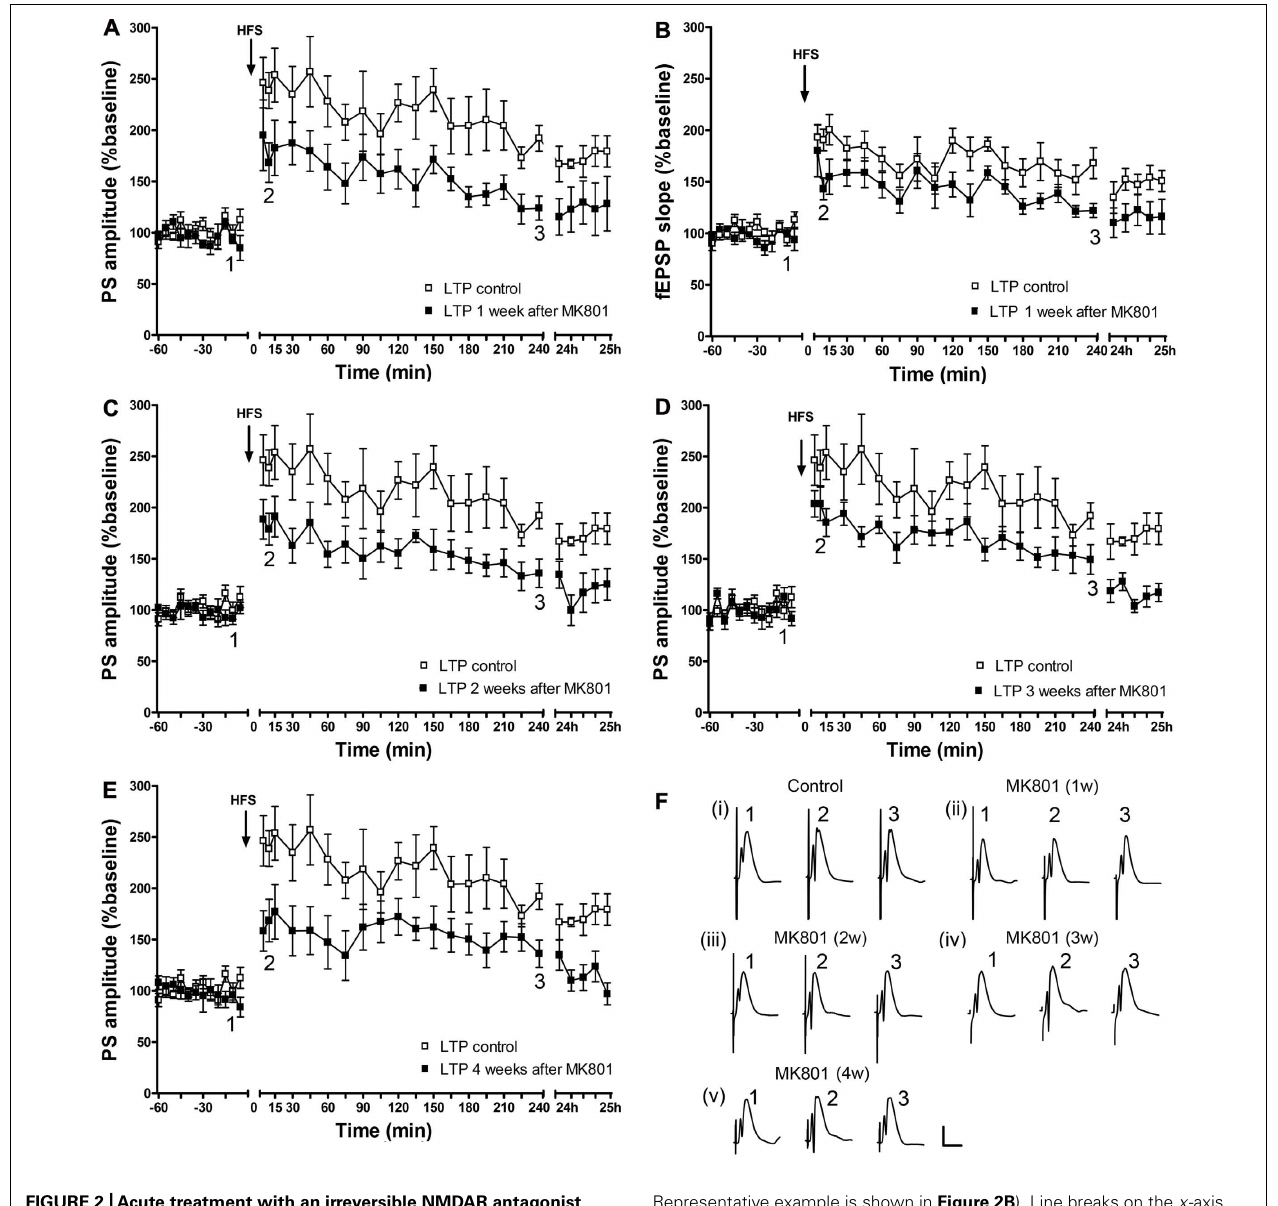
FIGURE 2 |Acute treatment with an irreversible NMDAR antagonist leads to a persistent long-term impairment of LTP in vivo , which lasts for at least 4 weeks. One week after MK801-treatment, LTP of population spike amplitude (A) and of fEPSP (B) are significantly impaired compared to control LTP ( n = 7).This impairment persists in the second ( n = 7) (C) , third ( n = 7) (D) , and fourth ( n = 7) (E) weeks after MK801-treatment (relative changes in fEPSP responses were equivalent to changes in PS